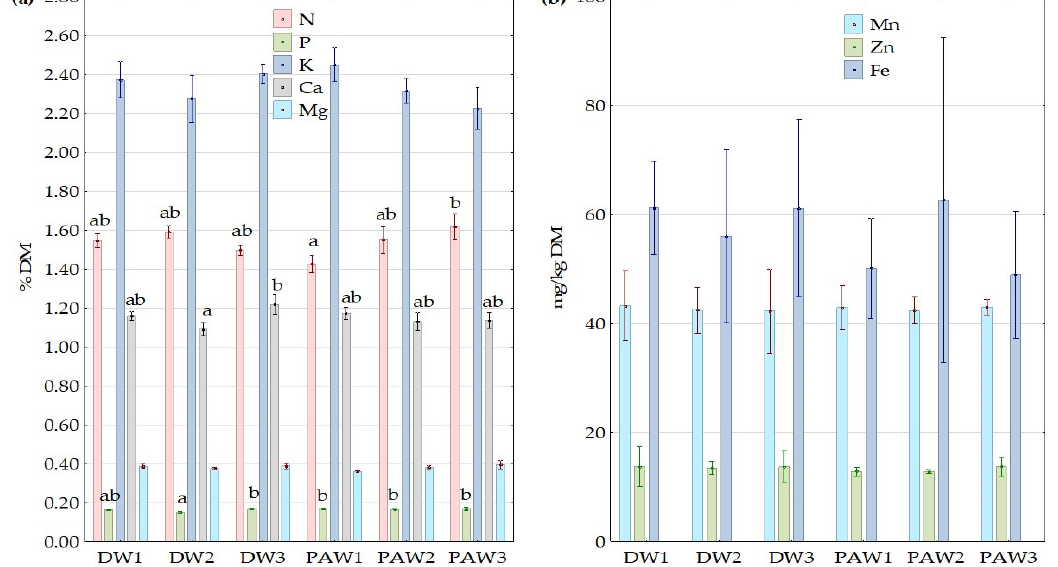
Figure 6. Content of ( a ) macro- and ( b ) micro-nutrients in above ground-biomass of plant. The mean values (n = 8) sharing the same letter are not significantly different from each other ( p ≤ 0.05) according to LSD test (each nutrient was evaluated separately). Lack of lettering indicates no significant differences between the mean values. Intervals present the mean standard error (SE).